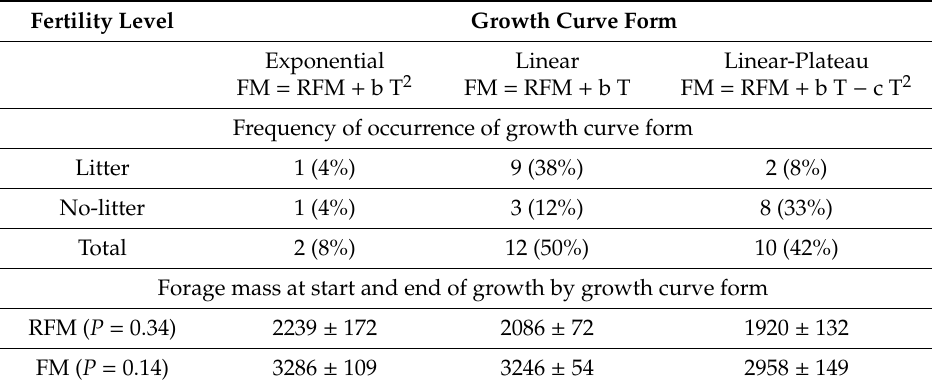
Table 2. Frequency of occurrence of growth curve form for pastures growing in May and June by fertility management (no poultry litter vs. litter at 4.5 or 9 metric tons ha − 1 yr − 1 ) vs. all pastures (N = 24). Mean ( ± SE) residual forage mass (RFM) at the end of the previous grazing and growth achieved at the end of regrowth (FM) (T in days from start of